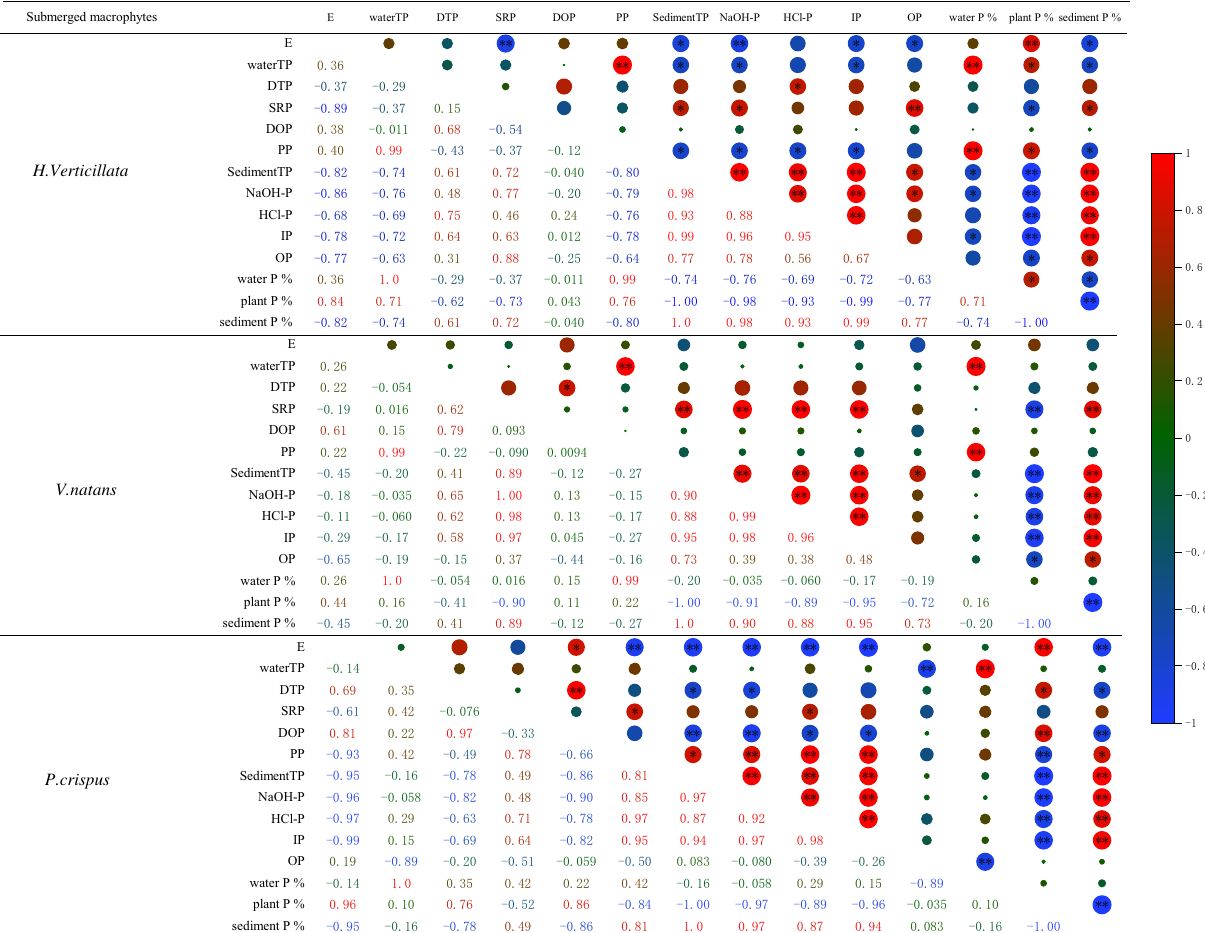
Table 3 Pearson correlation coefficients among different physical and chemical indicators and principal components of environmental fac- tors,